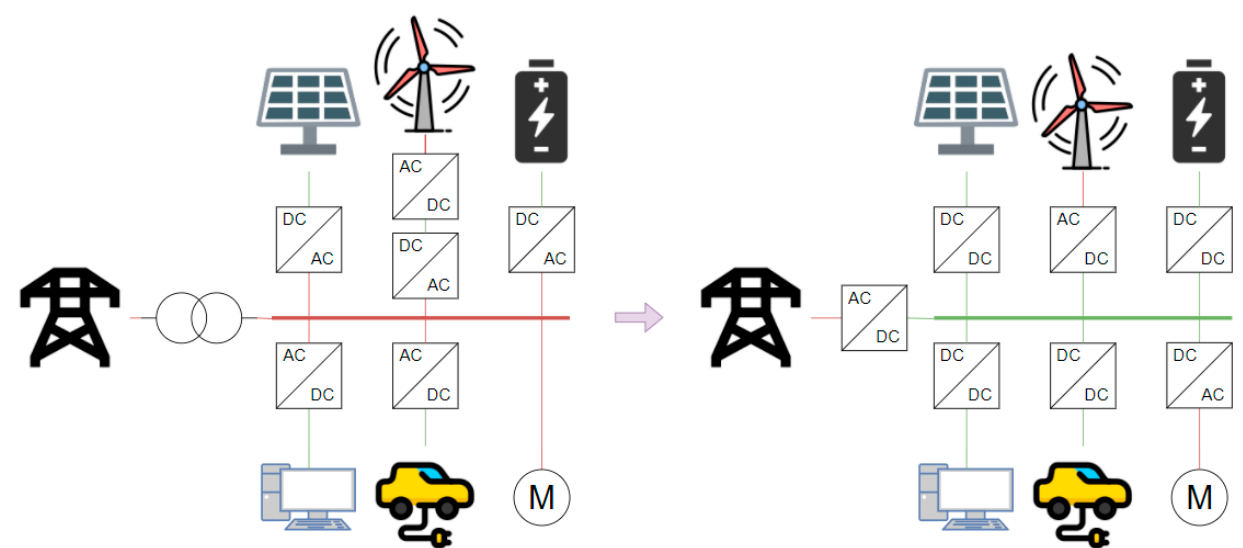
Figure 1. The transition from AC MGs to DC Figure 1 . The transition from AC MGs to DC MGs.